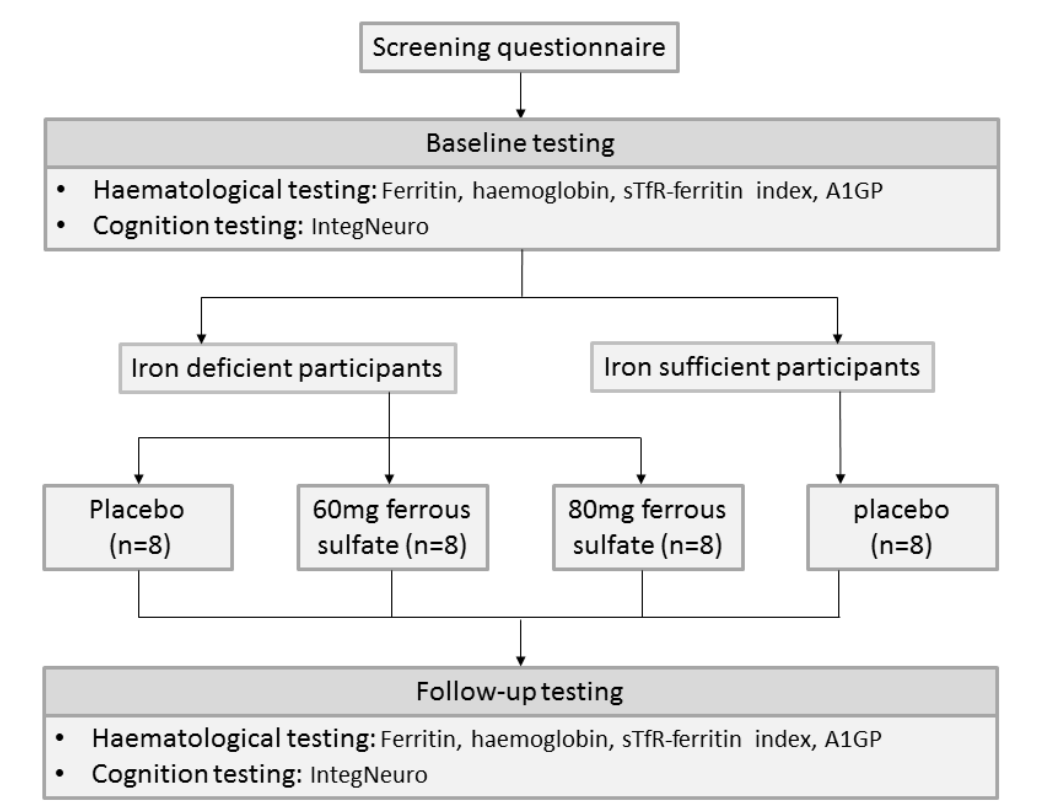
Figure 1. Flow chart describing the participant flow through a pilot double-blinded, placebo-controlled randomised control trial of the effect of iron supplementation (60 mg or 80 mg iron or placebo for 16 weeks) on the cognitive function of iron-deficient (ferritin < 20 μ g/L, haemoglobin ≥ 120 g/L) and iron-sufficient (ferritin ≥ 20 μ g/L, haemoglobin ≥ 120 g/L) women (18–35